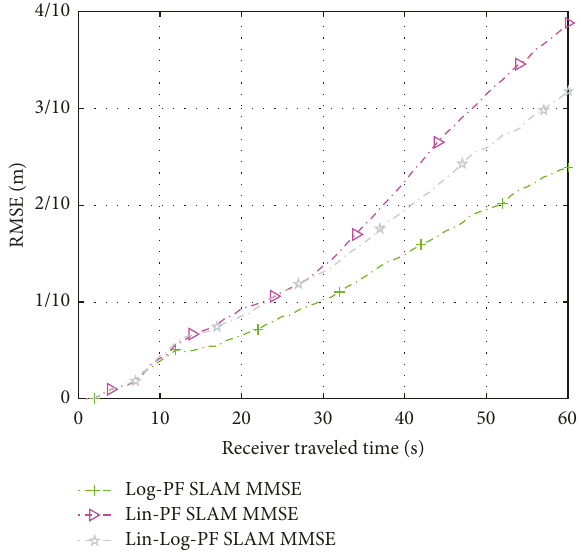
Figure 7: RMSEs of the estimated receiver positions versus receiver traveled time for different